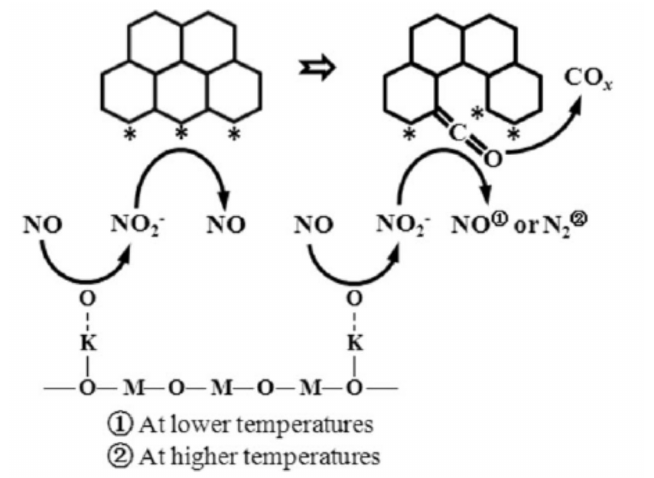
Figure 10. A nitrite-ketene mechanism for soot oxidation by NO [115]. M stands for metal and “*” stands for the free carbon sites on soot. Copyright 2011, Wiley Online